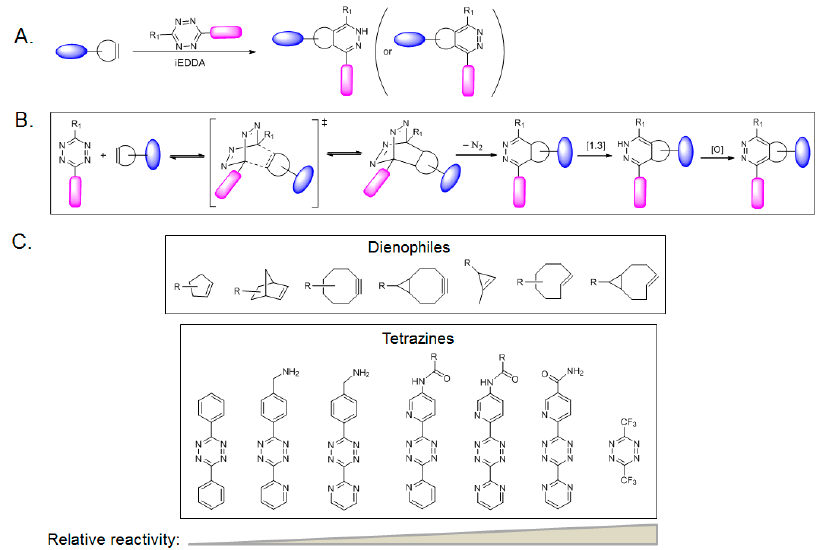
Figure 4. Tetrazine ligation of alkene-functionalized biomolecules through iEDDA: Schematic representation of: iEDDA ( A ); its mechanism ( B ); and several dienophiles and tetrazine derivatives with their relative reactivities ( C ).